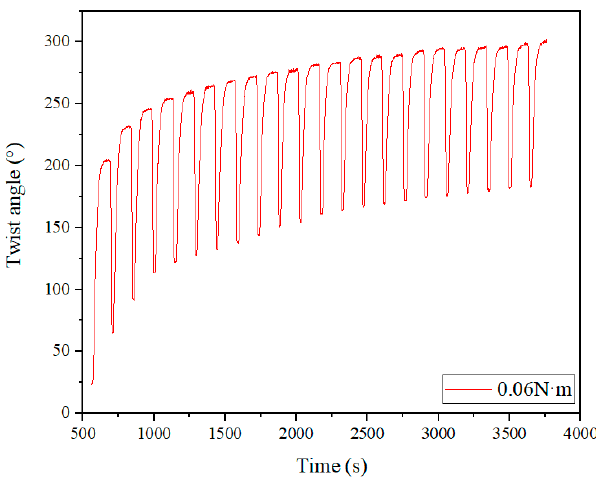
Figure 10. Twist angle–time curve of the SMAMS S2.